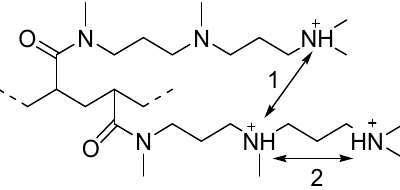
Figure 5. Scheme of electrostatic interactions in the P11 polymer.